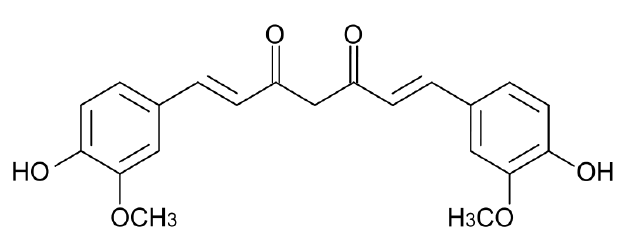
Figure 1. Curcumin